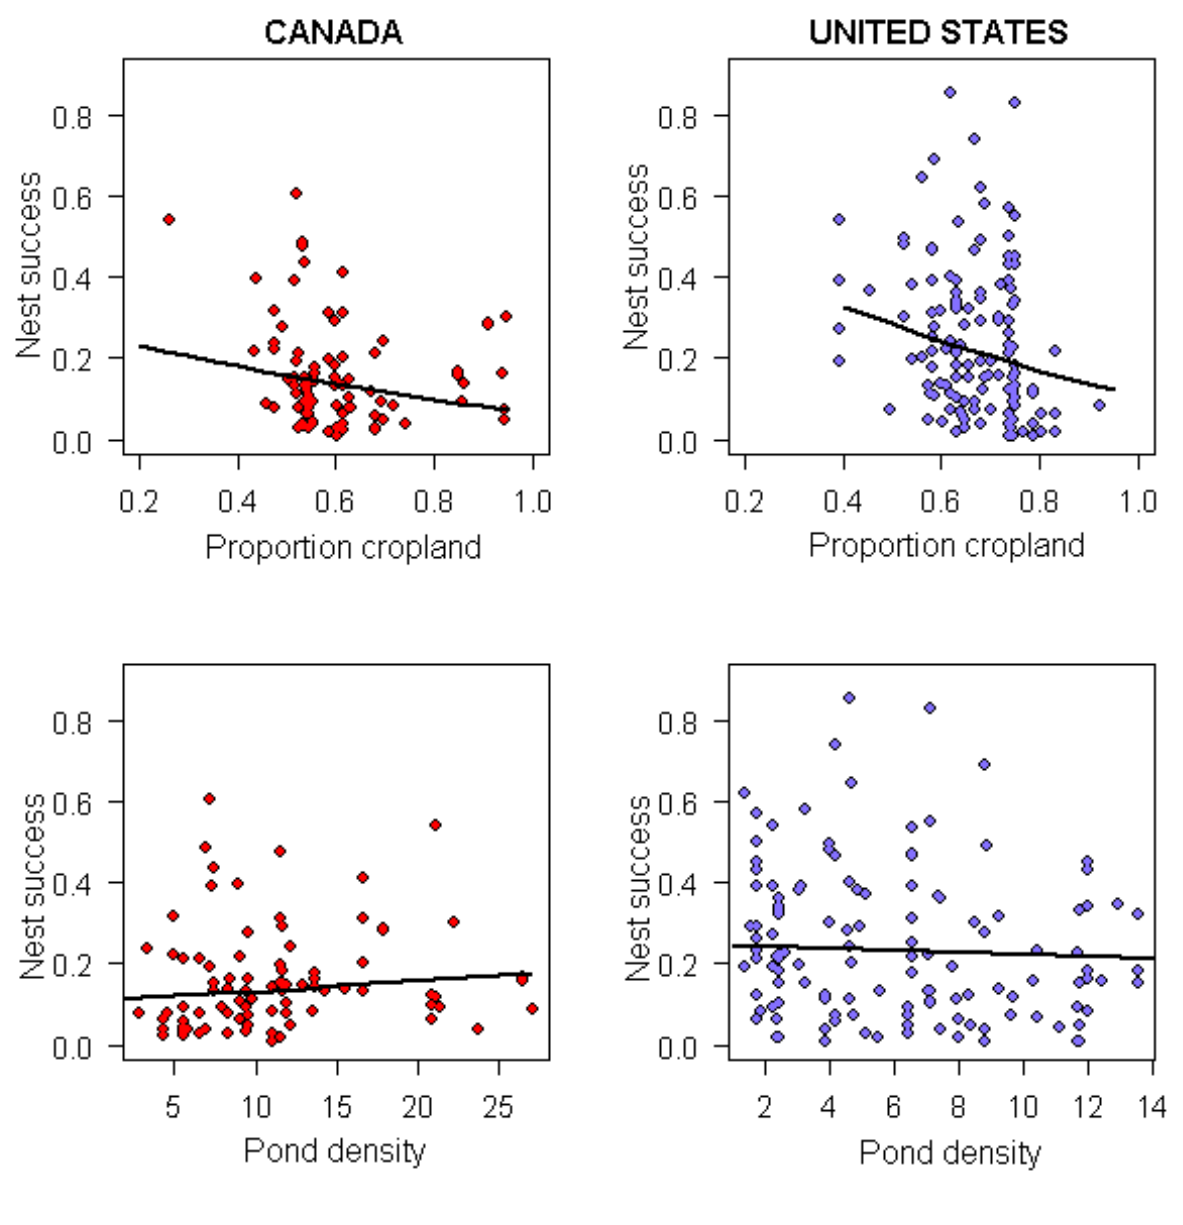
Fig. 3 . Mean nest success of dabbling ducks as a function of proportion cropland and pond density in the Pothole Prairie Region of Canada and the United States, 1964–1995. Nest success estimates were collected from published and unpublished studies. Agricultural data are from the Census of Agriculture collated by Miller (2000) and represent the proportion of strata from aerial waterfowl surveys (Smith 1995) covered in row crops. Lines indicate the model-averaged predicted values from 12 general linear mixed models depicting possible relationships between nest success, country, proportion cropland, and pond density. Note differences in the x -axes between countries with respect to pond